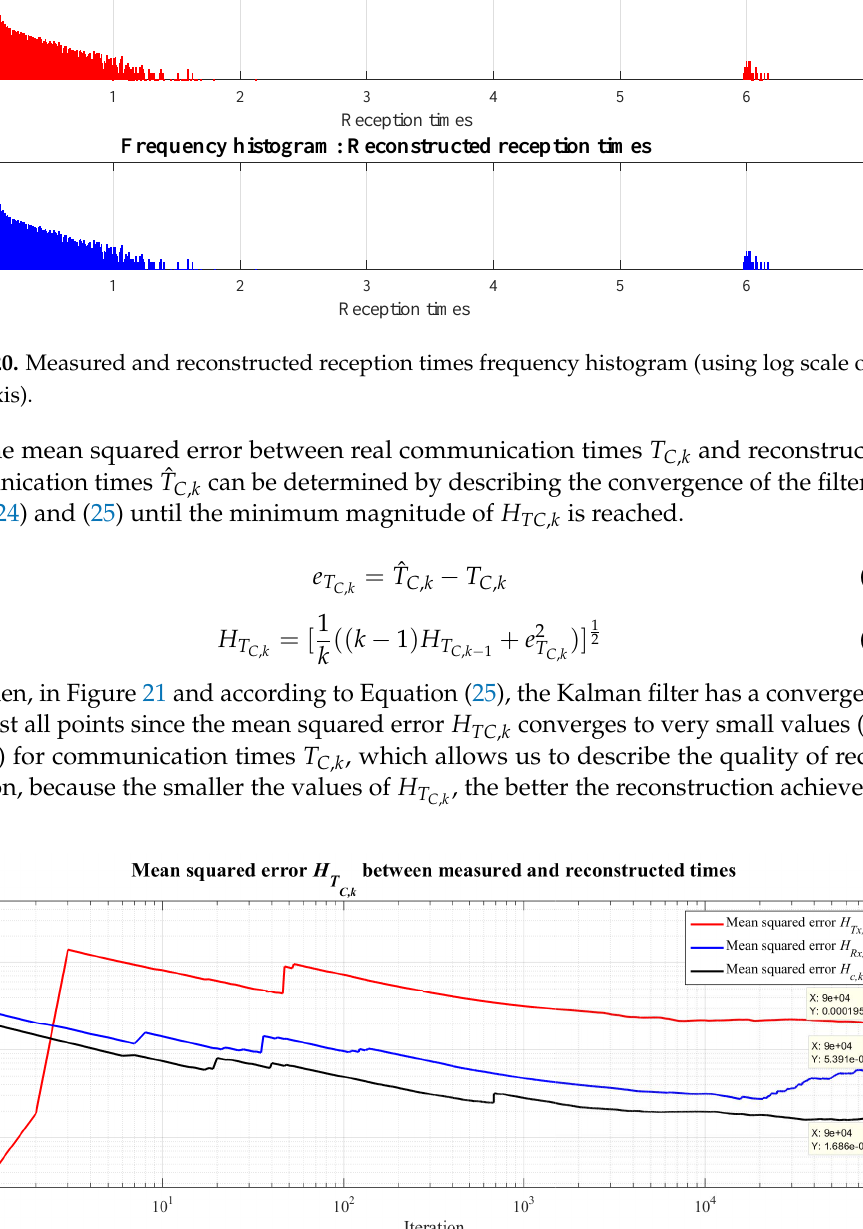
(using log scale on x - and y -axis). C , k C , k